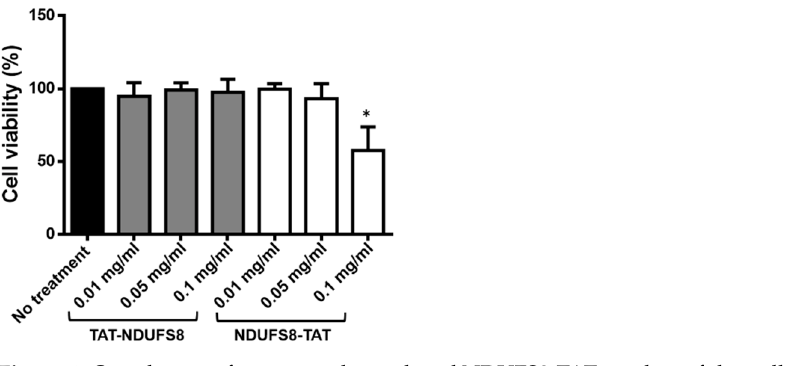
Figure 4. Overdosage of exogenously produced NDUFS8-TAT was harmful to cell viability. T-REx-293 cells were seeded in 96-well plates and incubated with the indicated concentration of TAT-NDUFS8 or NDUFS8-TAT for 48 h. Cell viability was measured by the MTT assay. Mean values of cell viability are shown as percentages relative to the untreated cells ( n = 3; * p < 0.05).